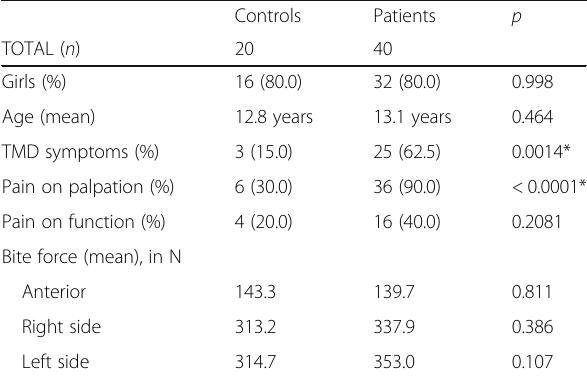
Table 1 Demographic and Temporomandibular Disorders (TMD) symptoms and signs and bite force measurement of patients and